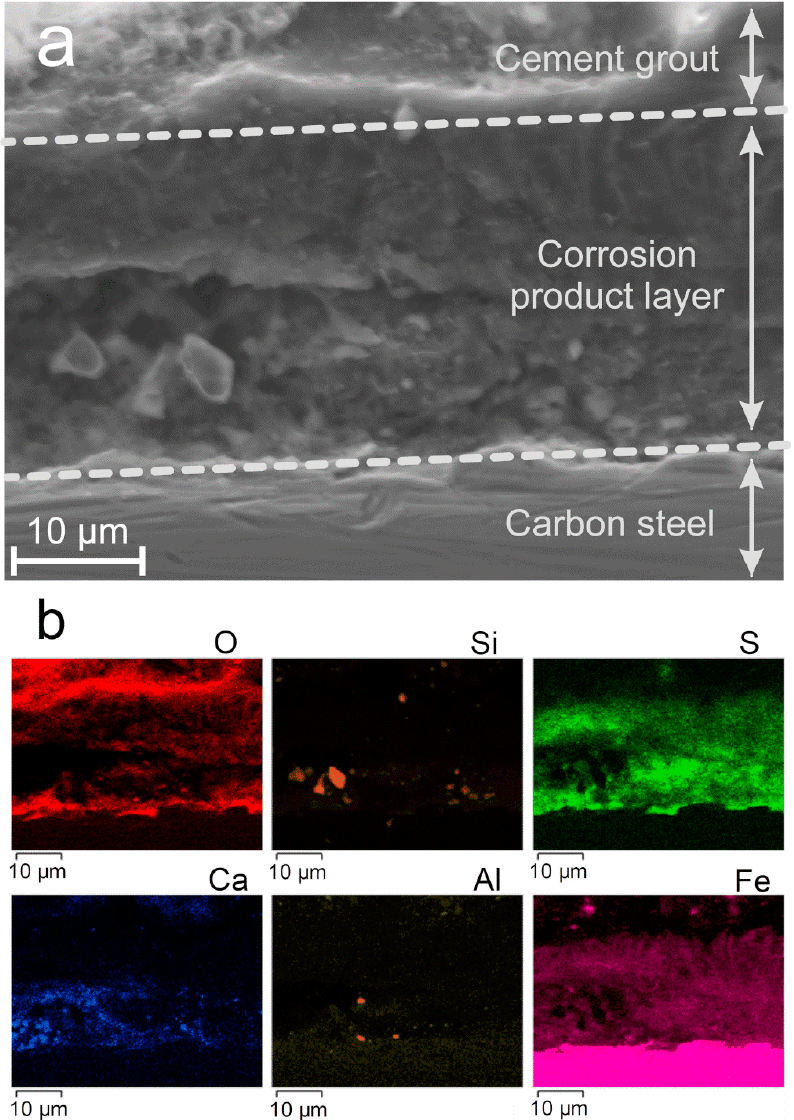
Figure 8. SEM image (secondary electrons) of the carbon steel/corrosion products layer/grout system (cross-sectional view) after the experiment ( a ) and corresponding EDS maps ( b ).